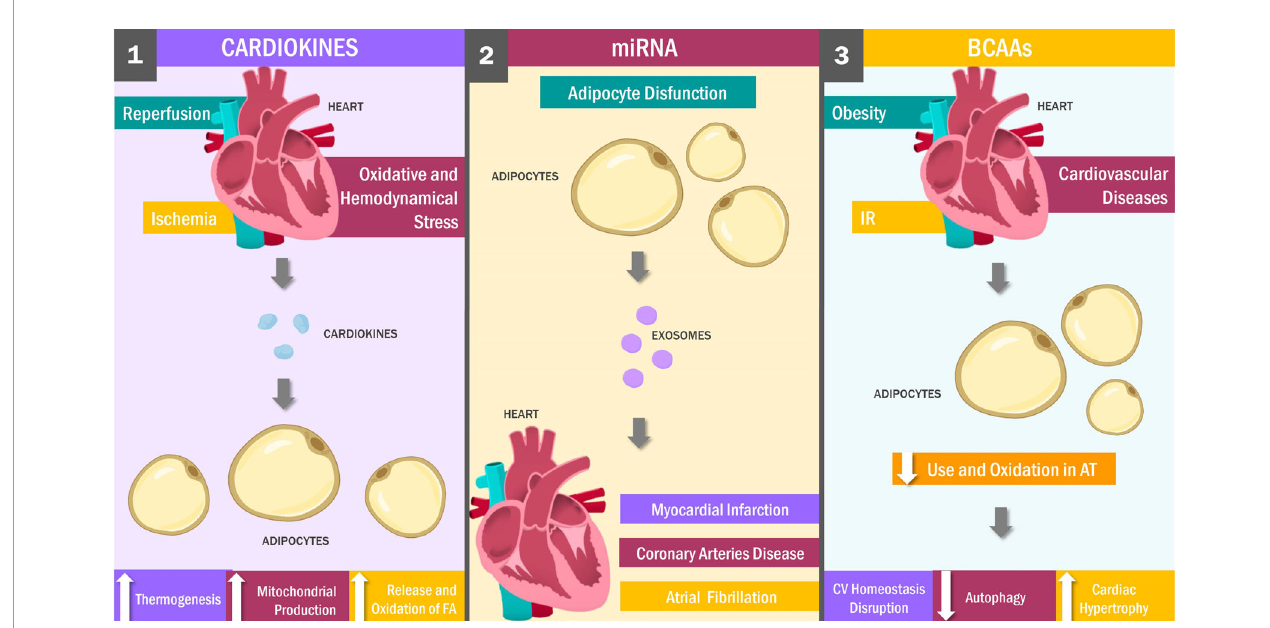
FIGURE 2 | Heart and Adipose Tissue Crosstalk: Key Messengers. Cardiokines: stimuli such as cardiac ischemia, reperfusion, oxidative and hemodynamic stress stimulate the production of cardiokines, which signaling in an endocrine and paracrine mechanism to the adipose tissue promoting weight loss by increasing thermogenesis and both the release and oxidation of fatty acids. Adipose tissue dysfunction is a stimulus for miRNAs release, which travel through the bloodstream to the myocardial tissue inside exosomes, exerting cardioprotective against myocardial infarction, coronary artery disease and atrial fi brillation. On the other hand, obesity, IR and cardiovascular diseases decrease BCAAs oxidation in adipose tissue, which decreases autophagy with heart hypertrophy and, fi nally, the alteration of the bioenergetic homeostasis of the heart. FA, Fatty Acids; AT, Adipose Tissue; CV, Cardiovascular; IR, Insulin